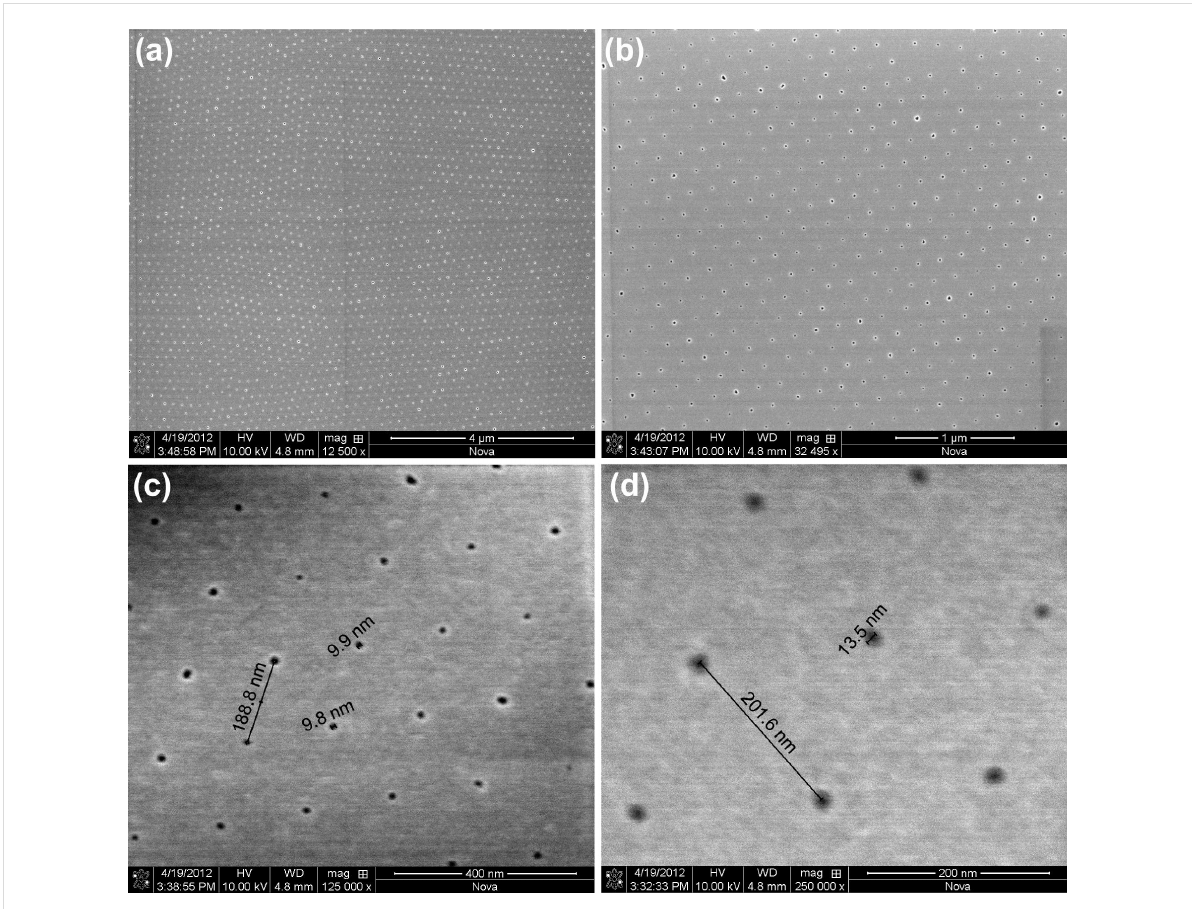
Figure 4: SEM images of a typical colloidal-monolayer mask, shown on four scales in (a–d). The average interdot distance is 200 nm (c,d), corres- ponding to the original polystyrene particle diameter. The average dot size is variable by adjustment of the ICP etching time, and reaches down the sub-10 nm range (c). (d) Shows a mask close-up with a nearly perfect hexagonal-close-packed pattern, with a lattice constant of 200 nm and a hole diameter of 13 nm. (a–d) correspond to different sections of the same